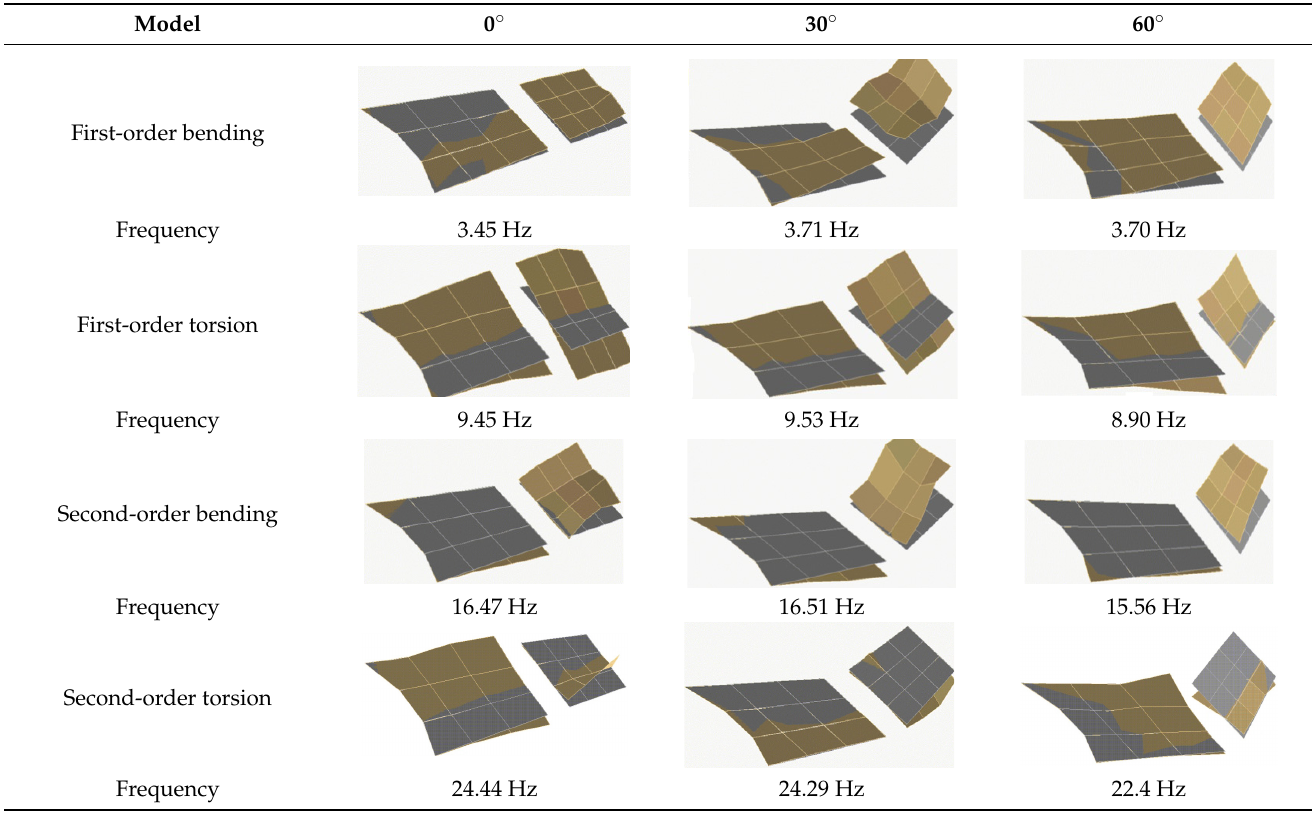
Table 3. Vibration characteristics of the experimental model at different folding foot degrees.